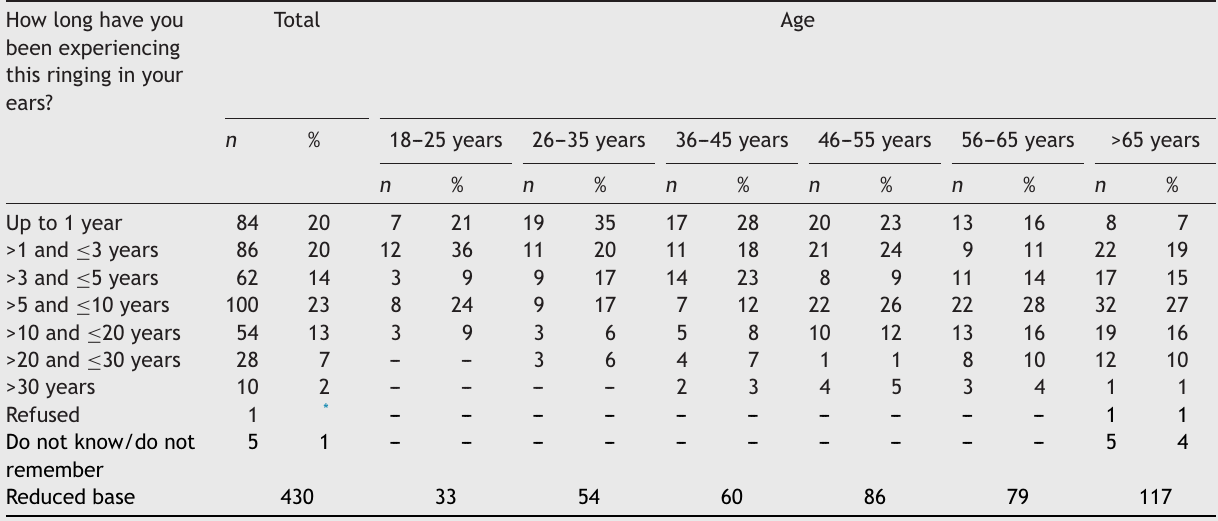
Time of duration of reported tinnitus, according to the different age groups in the population of the city of São Paulo.